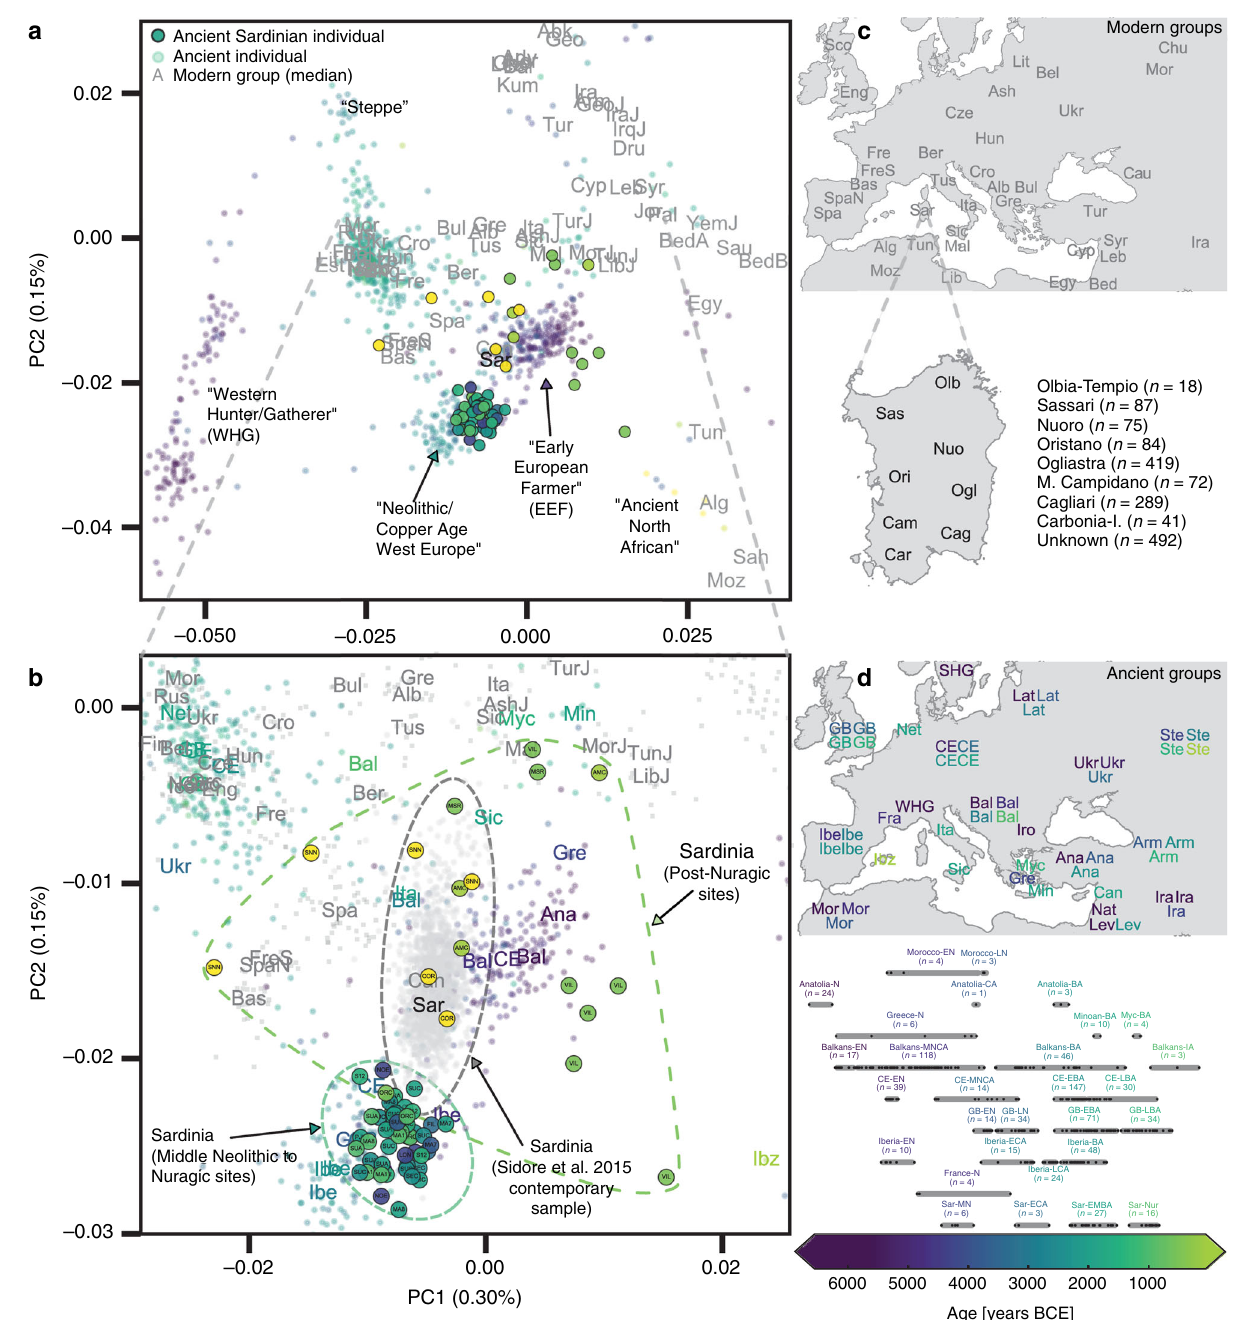
Fig. 2 Principal components analysis based on the Human Origins dataset. a Projection of ancient individuals ’ genotypes onto principal component axes de fi ned by modern Western Eurasians and North Africans (gray labels, see panel ( c ) for legend for all abbreviations but ‘ Can', for Canary Islands). b Zoom into the region most relevant for Sardinia. Each projected ancient individual is displayed as a transparent colored point in panel ( a ) and ( b ), with the color determined by the age of each sample (see panel ( d ) for legend). In panel ( b ), median PC1 and PC2 values for each population are represented by three- letter abbreviations, with black or gray font for moderns and a color-coded font based on the mean age for ancient populations. Ancient Sardinian individuals are plotted as circles with edges, color-coded by age, and with the fi rst three letters of their sample ID (which typically indicates the archeological site). Modern individuals from the Sidore et al. sample of Sardinia are represented with gray circles and modern individuals from the reference panel with gray squares. See Fig. 5 for a zoomed in representation with detailed province labels for Sardinian individuals. The full set of labels and abbreviations are described in Supp. Data 1E, F. c Geographic legend of present-day individuals from the Human Origins and our Sardinian reference dataset. d Timeline of selected ancient groups. Note: The same geographic abbreviation can appear multiple times with different colors to represent groups with different median